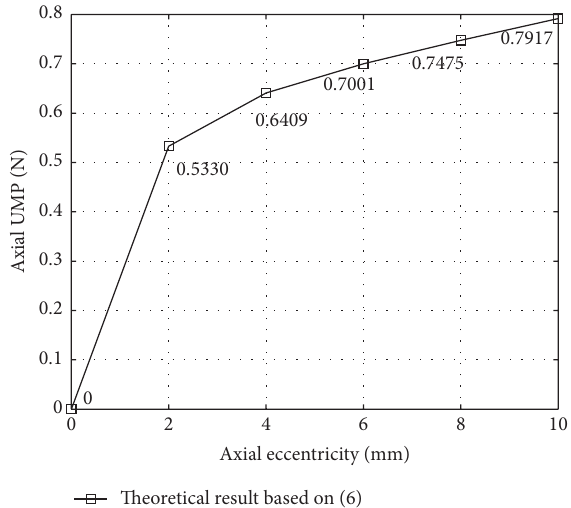
Figure 5: Relationship between AAGE and UMP based on (6).